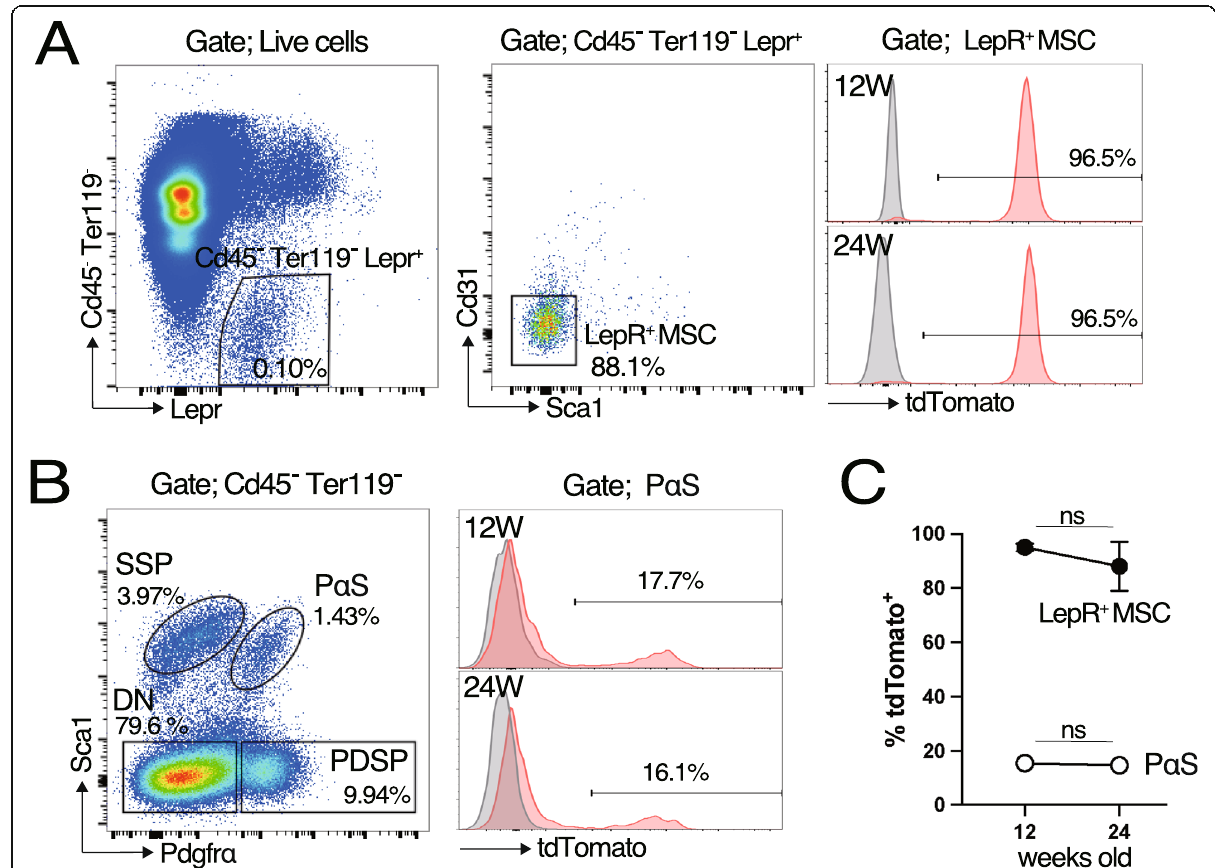
Fig. 4 LepR-tdTomato labels LepR + MSC and some P α S in the long bones. Expression of tdTomato in LepR + MSC ( A ) and P α S ( B ) from LepR- tdTomato at 12 and 24 weeks of age. ( C ) Time course changes in tdTomato positivity in LepR + MSC and P α S are shown ( n